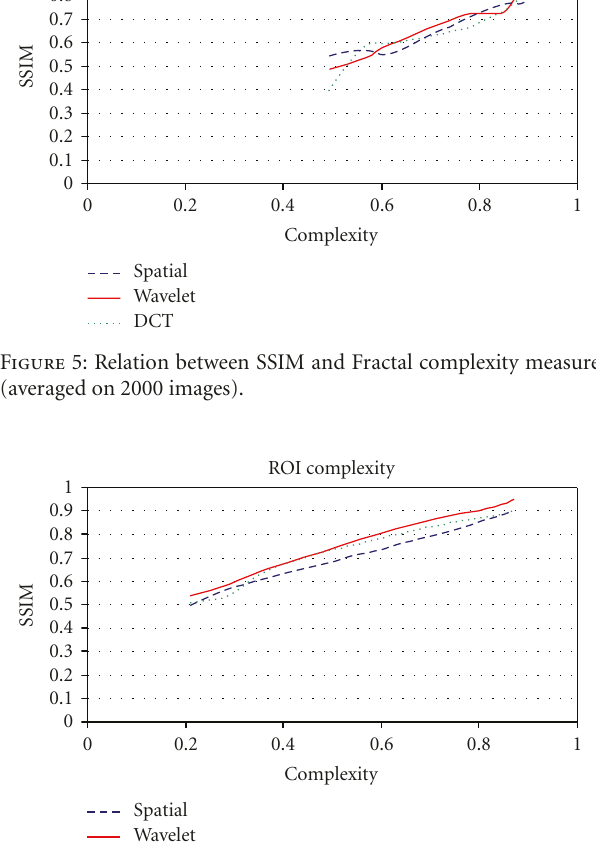
Figure 8: Relation between JND and Quad tree complexity measure (averaged on 2000